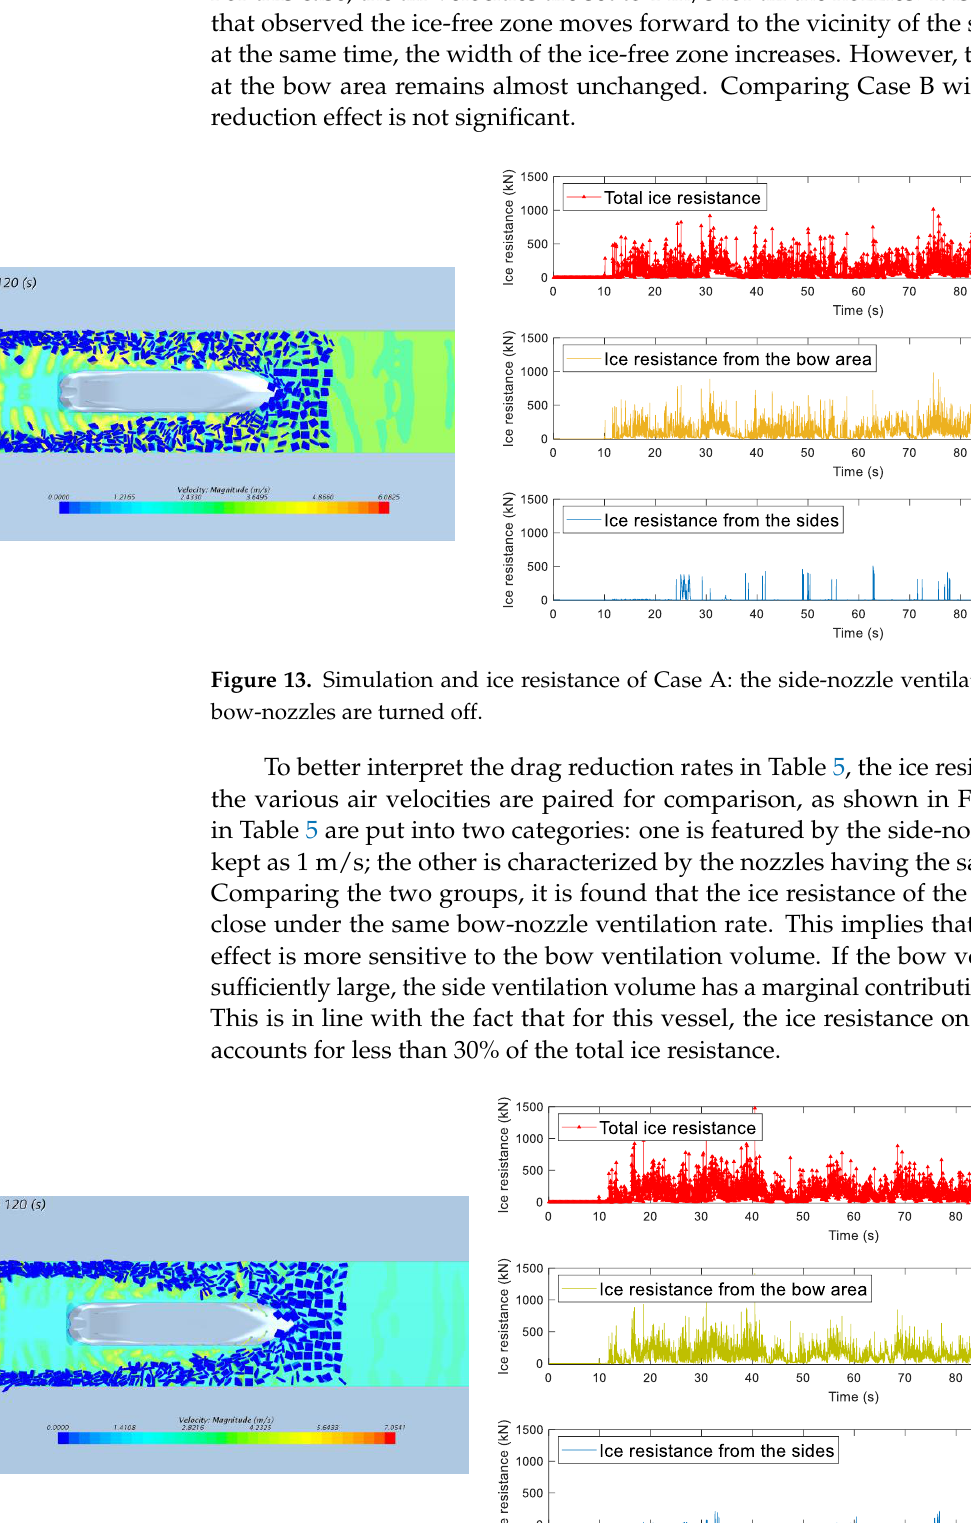
Figure 14. simulation and ice resistance of Case B: the side-nozzle ventilation rate is kept as 1 m/s; the bow nozzles are turned on as 1 m/s.